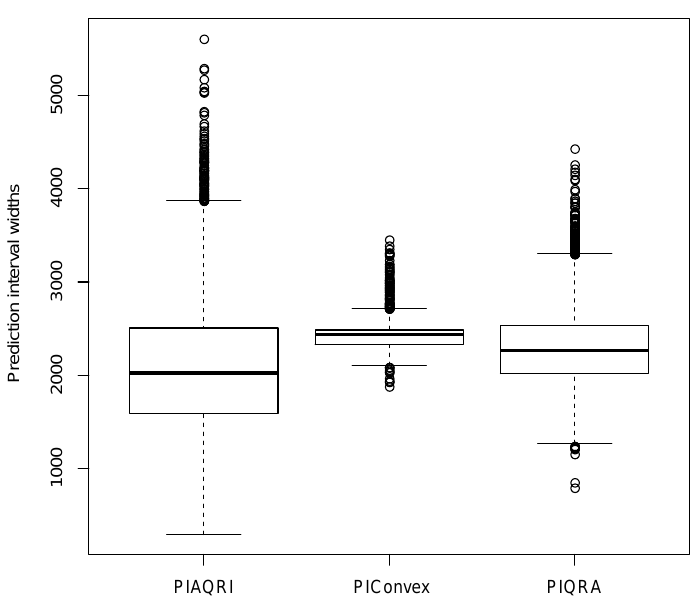
Figure 5. Prediction interval widths for models M 4 (PIAQRI), M 5 (PIConvex) and M 6 (PIQRA).